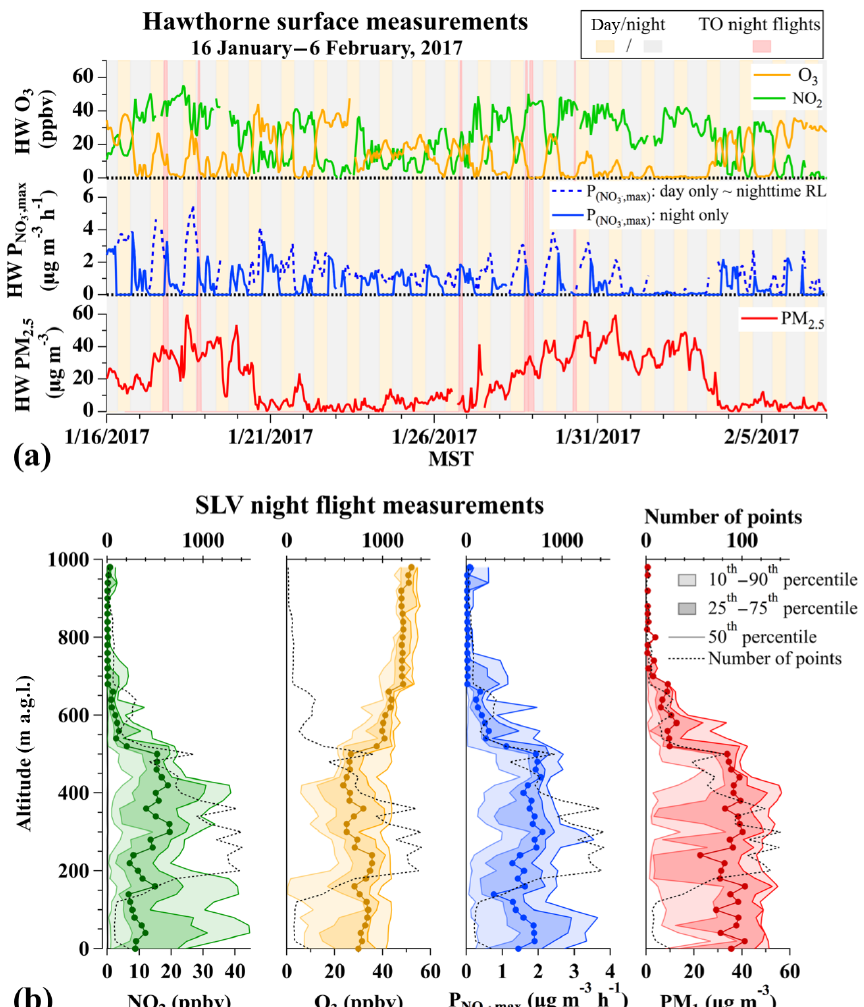
Figure 6. (a) Time series of NO 2 , O 3 (top), P (middle; see text for definition), and PM 2 . 5 (bottom) measured at the HW ground site NO − 3 , max during 16 January–6 February 2017. O 3 data during the middle January pollution event were corrected to account for a 4.5ppbv offset in the HW measurements, as shown in Fig. S4. Aircraft flight times are shown by red shading. Dashed blue line shows the calculated P NO − 3 , max rates that would occur during the day if this mechanism were operative. Solid blue line assumes nitrate production from this mechanism during the day is zero. Late-afternoon P at the surface (dashed line) is roughly equivalent to the P expected in the RL at NO − 3 , max NO − 3 , max night. (b) Vertical profiles of O 3 , NO 2 , P (1s data), and PM 1 (10s data) measured from the aircraft on all night flights over the SLV. NO − 3 , max In each panel, light shaded regions show the 10th–90th percentile ranges, dark shaded regions are the 25th–75th percentile ranges, and the solid lines are the 50th percentile. Dashed black lines show the number of points at each